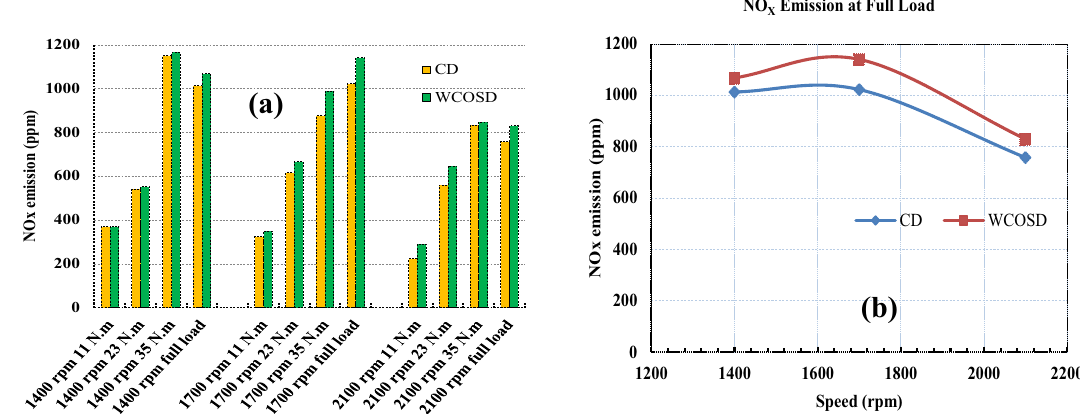
Fig. 8 NO x emissions of the test engine fueled CD and WOCSD at a 1400 rpm, 1700 rpm, 2100 rpm and b full load